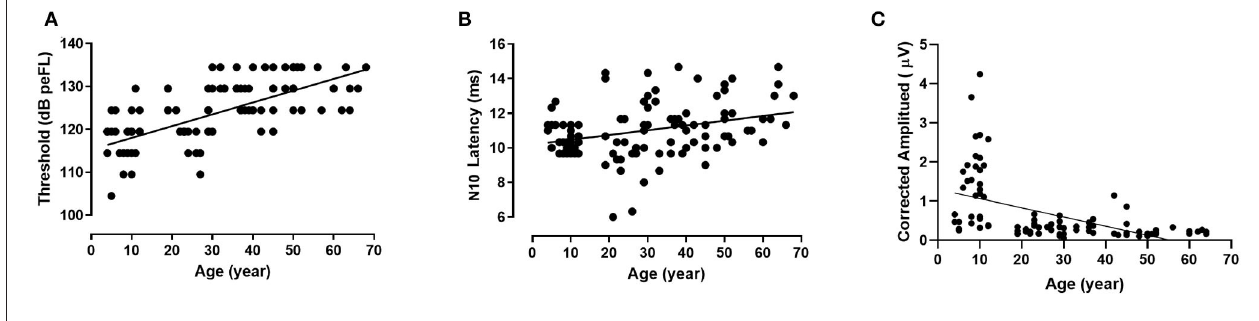
FIGURE 4 | Relationship between age and individual B81-oVEMP parameters (linear regression). The threshold (r 2 = 0.470, p = 0.000, p < 0.01) (A) and N10 latency (r 2 = 0.107, p = 0.000, p < 0.01) (B) of B81-oVEMP are positively correlated with age, whereas the corrected amplitude (r 2 = 0.266, p = 0.000, p < 0.01) (C) is negatively correlated with